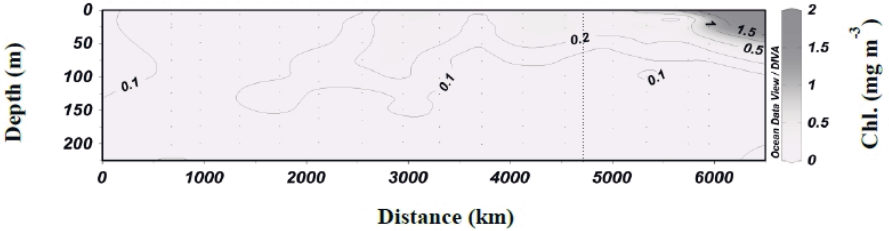
Figure 3. Cross section of sea water temperature, salinity, nitrate (NO 3 − ), phosphate (HPO 42 − ) and chlorophyll content, from CTD data in the upper 200 m of the water column. In each graph, the dotted line demarcates the western and eastern parts of the subtropical gyre (WSTG and ESTG).